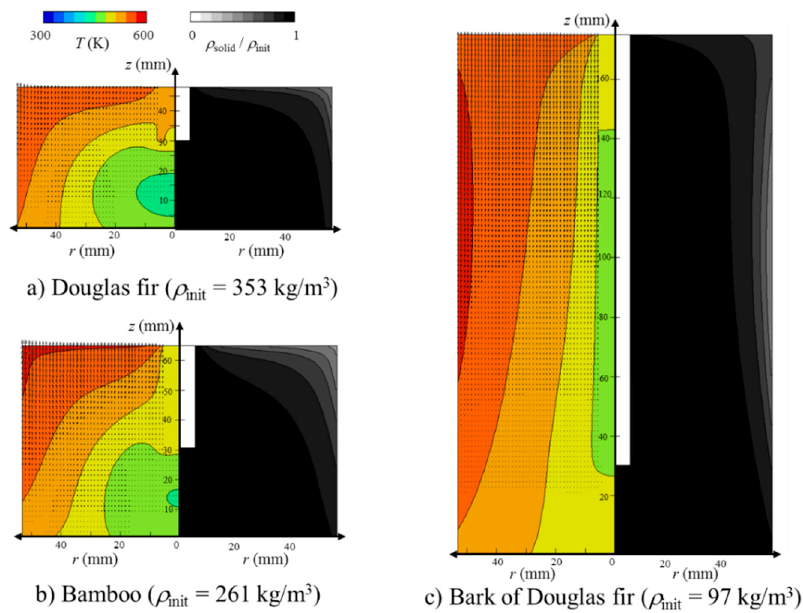
Figure 7. Calculation results for temperature, velocity vectors and solid distributions at 75 min during torrefaction for various kinds of biomass.